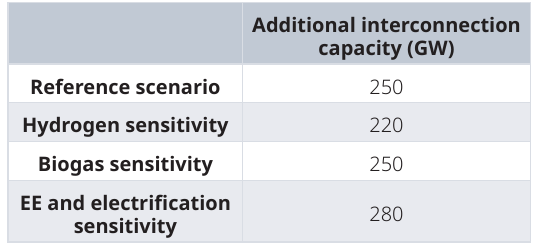
Table 1. Additional interconnection capacity (GW) per